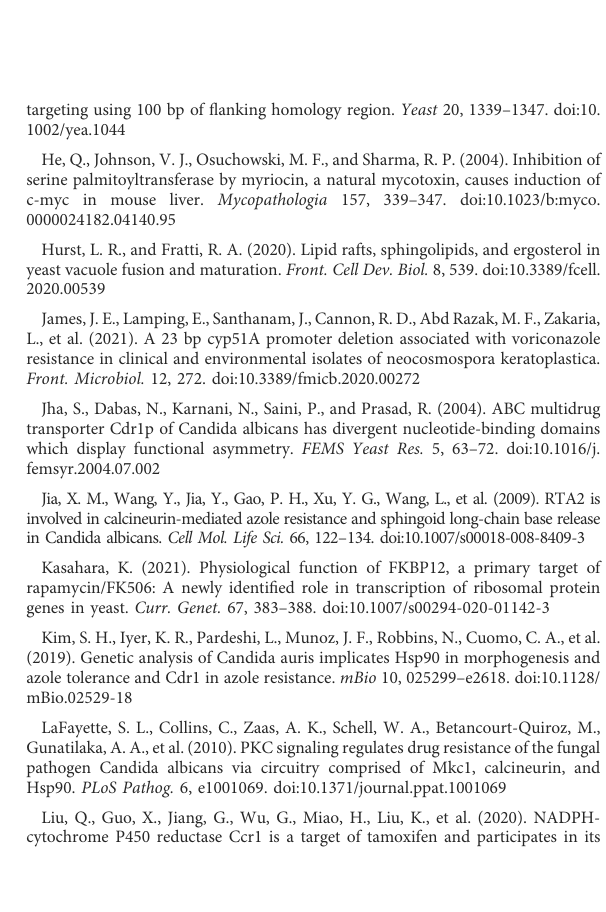
SUPPLEMENTARY FIGURE S4 The qRT-PCR analysis demonstrated that myriocin (0.5 μ g/mL) induced the expression of the CDR1 gene. SUPPLEMENTARY FIGURE S5 (A) The C-termini of Cdr1 with a GFP tag mutant was checked by